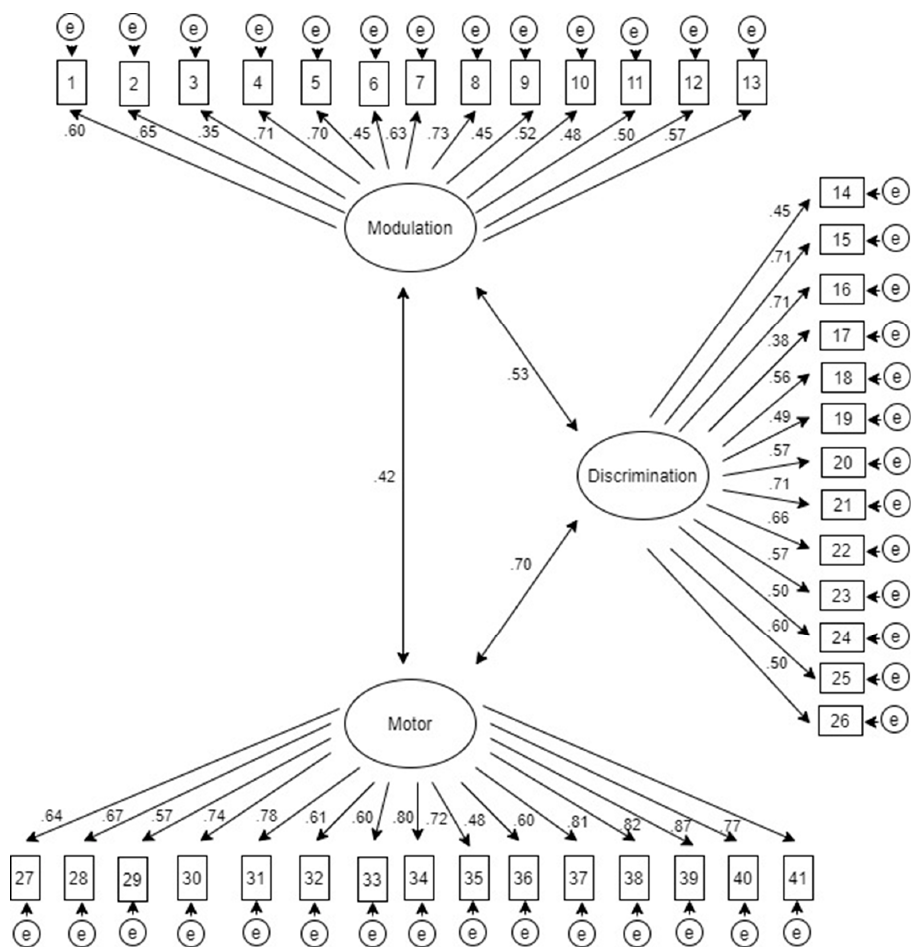
Figure 2. The Behavioral Observation on Sensory Stimuli Questionnaire for Parents’ (BOSS-P) graphical representation after confirmatory factor analysis (CFA).